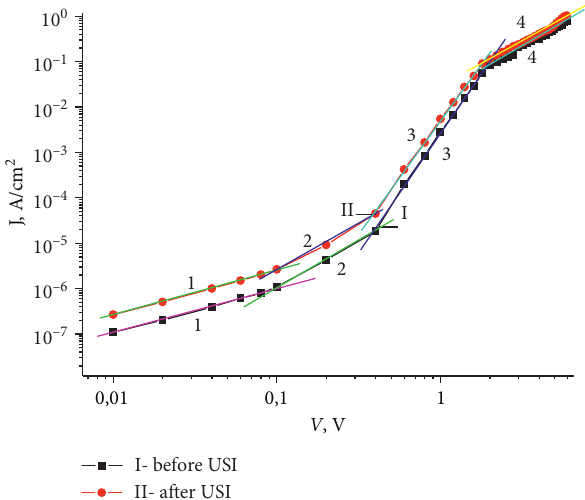
Figure 3: I-V characteristics of the type J ∼ V α with different slopes for the forward direction of the current before and after the UST. I